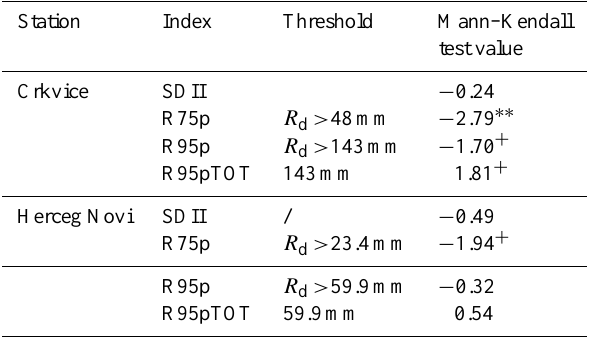
Table 5. Trend analysis of precipitation extremes (with statistical significance values) for the Crkvice and Herceg Novi station.